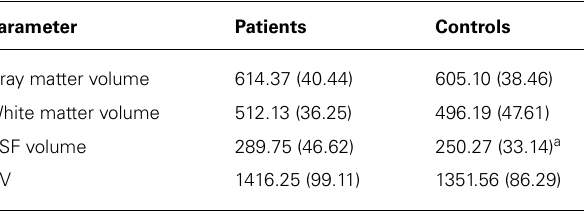
Table 3 | Global volumes (in ml) of brain tissues and fluids.